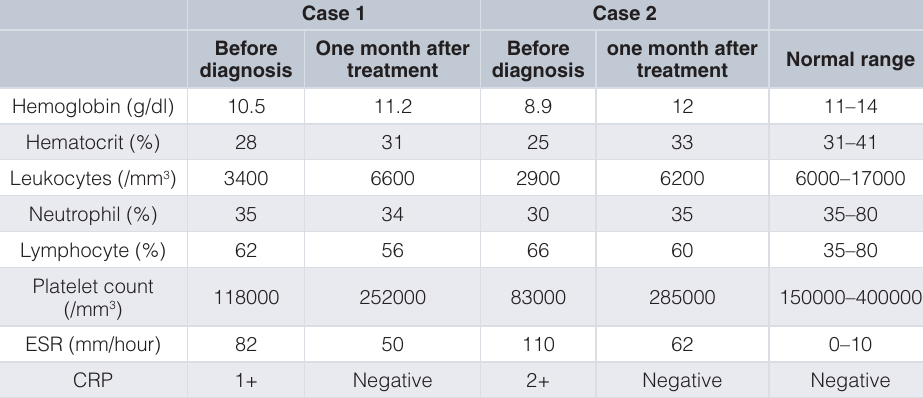
Table 1. Laboratory blood test results of the cases on admittance and one month after treatment.